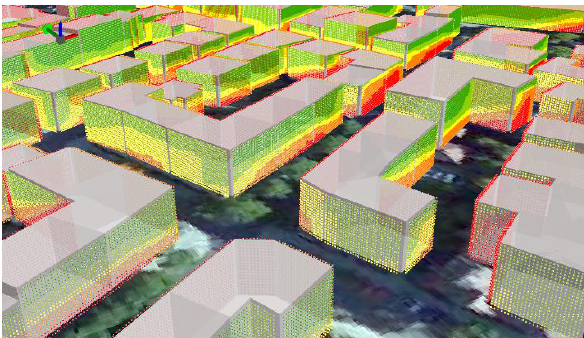
Figure 9. Differentiation of solar energy received on vertical walls during summer. Green observer points indicate insulation, red ones shadowing.